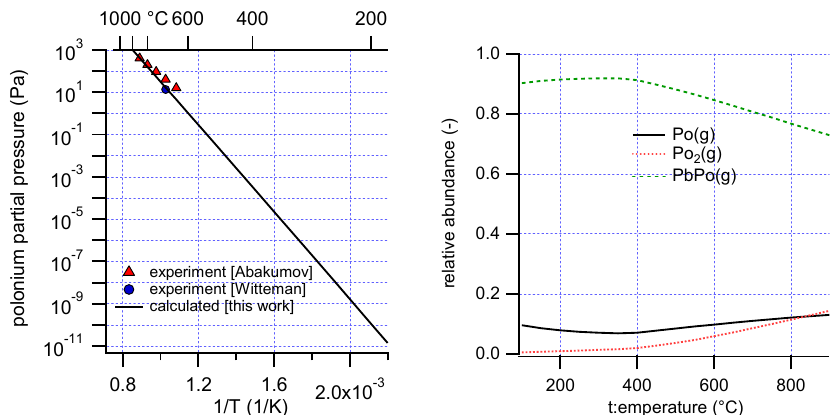
Figure 3. ( left ) Experimental data for vapor pressure of PbPo (markers) and calculated values (solid line). ( right ) relative abundance of Po vapor species in equilibrium with PbPo (Pb(g) vapor species not shown).